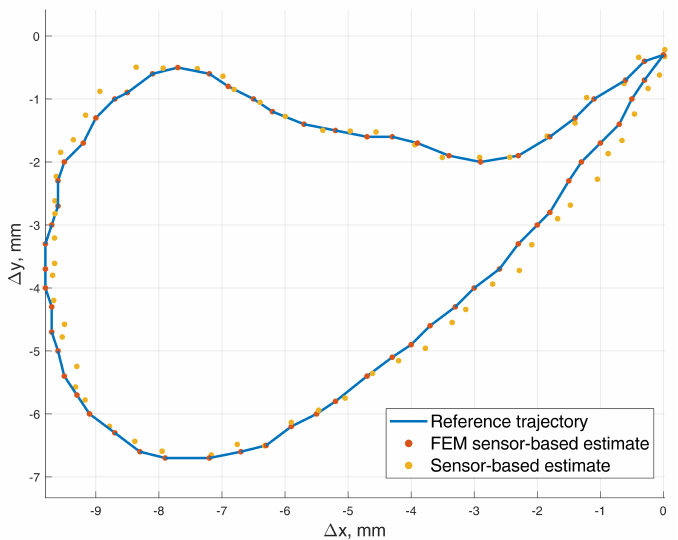
Figure 8. Original input trajectory and determined trajectory while using BMF (Background magnetic field) compensation. Finite element model simulation, RMSE = 0.05 mm (red), and prototype sensor– based data with real BMF, RMSE = 0.28 mm